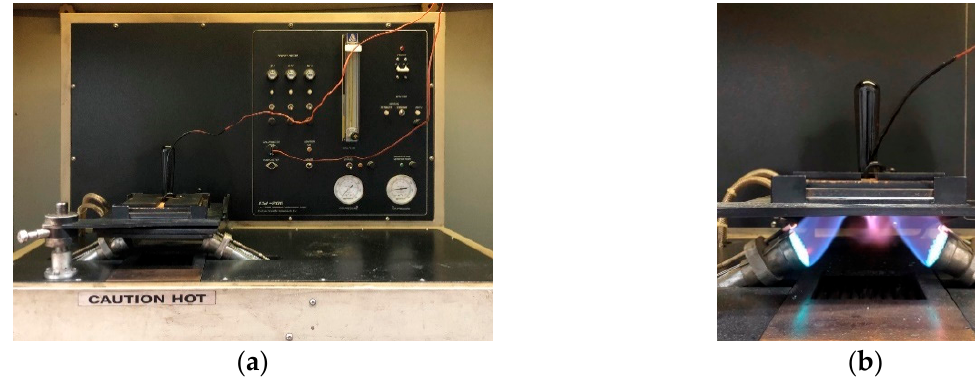
Figure 1. Test apparatus employed in this study: ( a ) thermal protective performance (TPP) tester; ( b ) TPP tester during flame experiment.